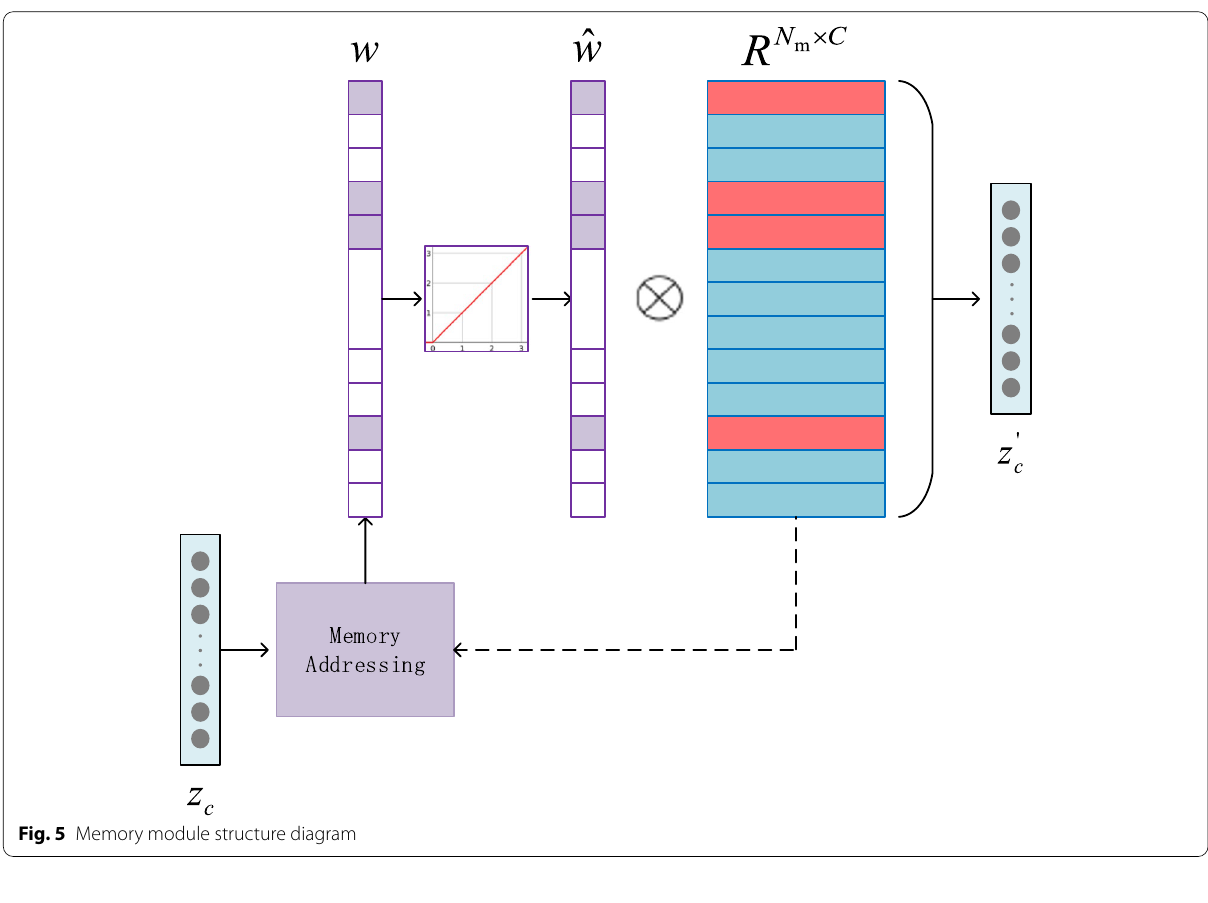
Fig. 5 Memory module structure